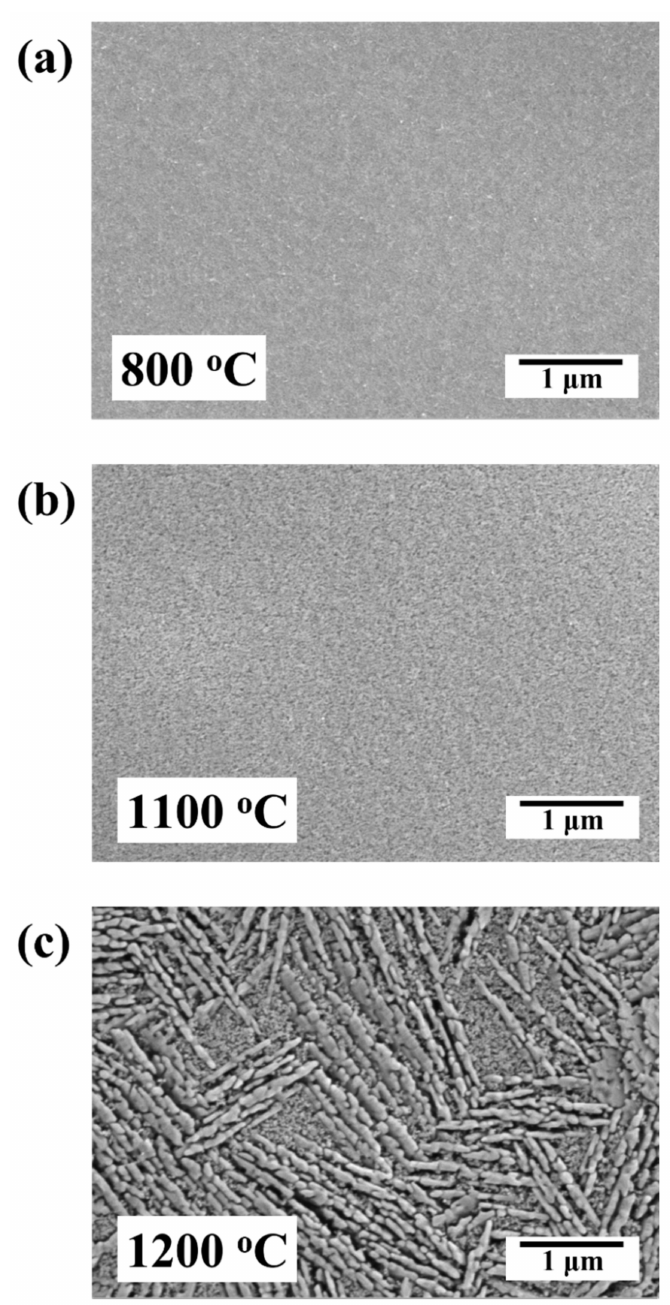
Figure 7. Top surface SEM micrographs of the Al 2 O 3 ultrafiltration (UF) membranes; ( a ) γ -Al 2 O 3 membrane sintered at 800 ◦ C, ( b ) α -Al 2 O 3 membrane sintered at 1100 ◦ C, ( c ) α -Al 2 O 3 membrane sintered at 1200 ◦